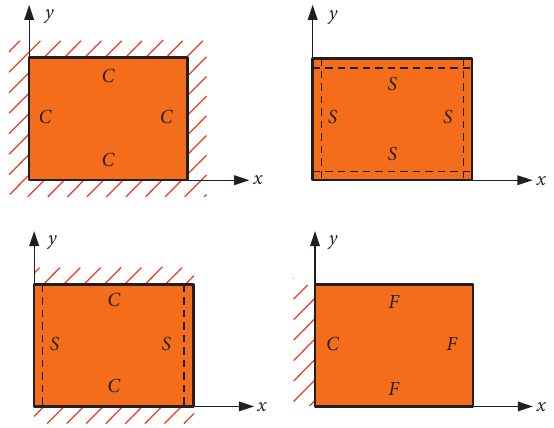
Figure 2: Boundary conditions of nano FGM plates. h 3 / q a 4 ) w (( a /2 ) , ( b /2 )) of square FGM plates ( a / h � 10) subjected to uniformly dis- c 0